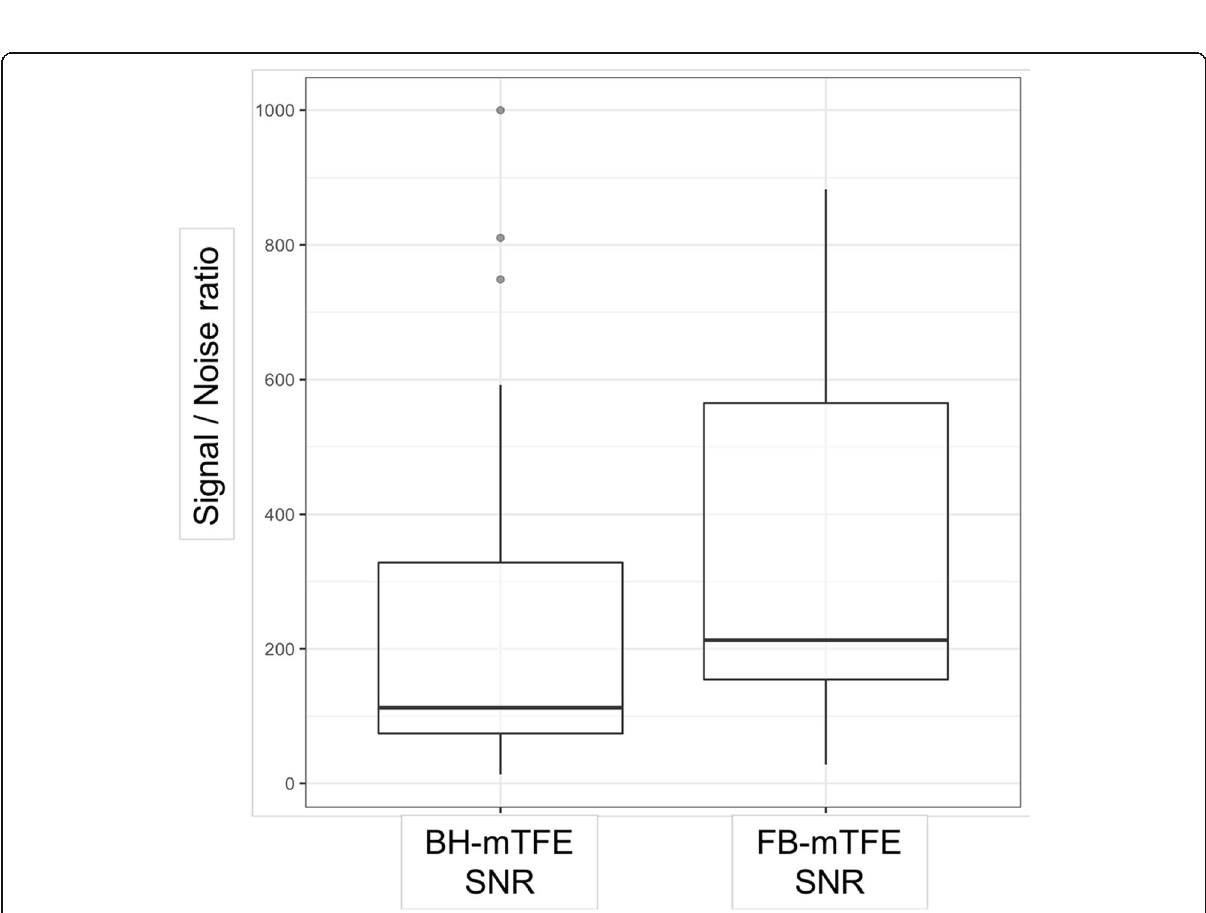
Fig. 2 Boxplots of the signal-to-noise ratio (SNR) for breath-holding (BH-mTFE) and free-breathing (FB-mTFE) sequences. SNR of BH-mTFE = 112.6, interquartile range 71.1 − 334.1. SNR of FB-MTFE = 212.8; interquartile range 148.5 − 566.5. (cid:129)